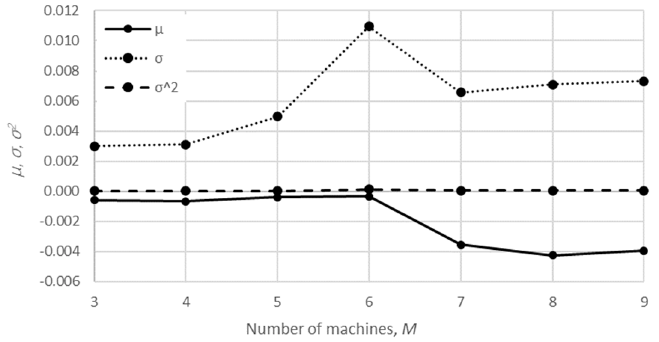
Figure 8. The relative error of the PR concerning the number of machines—AGG procedure.